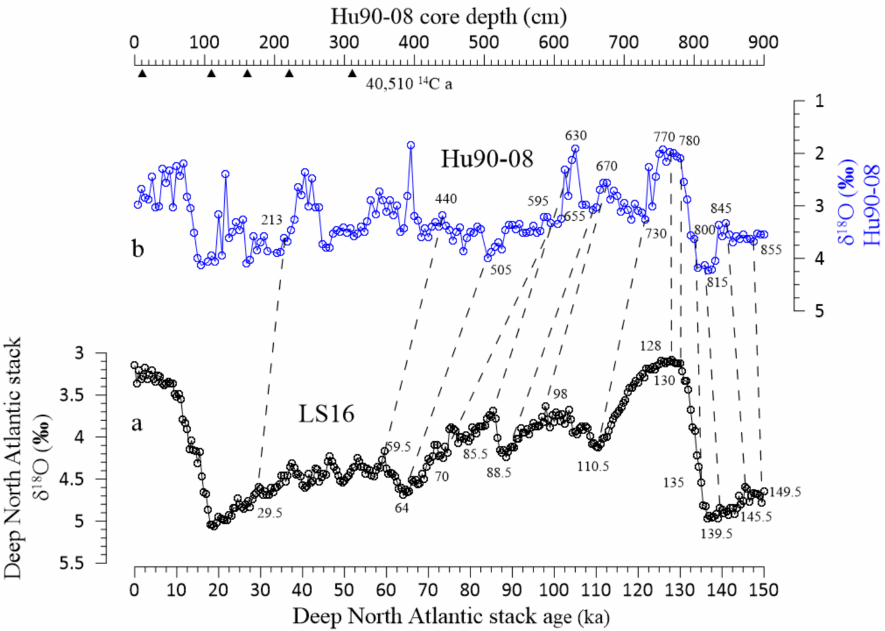
Figure 3. ( a ) Deep North Atlantic benthic foraminiferal δ 18 O stack [47] and ( b ) δ 18 O in the planktonic foraminifera N. pachyderma of core Hu90-08 (this study) are plotted. Fourteen tie points (Table 2) were obtained by visually aligning the δ 18 O values of Hu90-08 with those of the δ 18 O values of Lisiecki and Stern [47] and five 14 C-Accelerator Mass Spectrometry (AMS) dates (Table 2) to construct the age model of core Hu90-08. Note that the upward triangles ( b ) denote the position of 14 C-AMS dates.